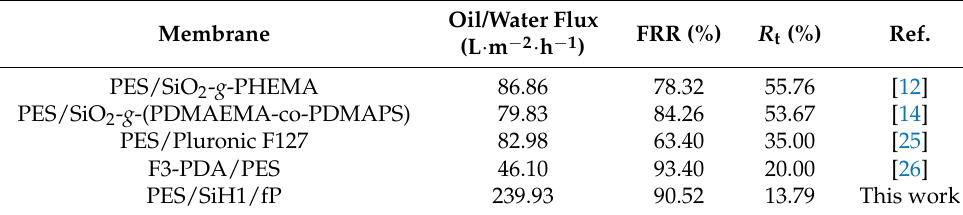
Table 2. A comparison of the PES/SiH1/fP membrane with other PES membranes on oil–water flux, the flux recovery ratio, and the total flux decline ratio.